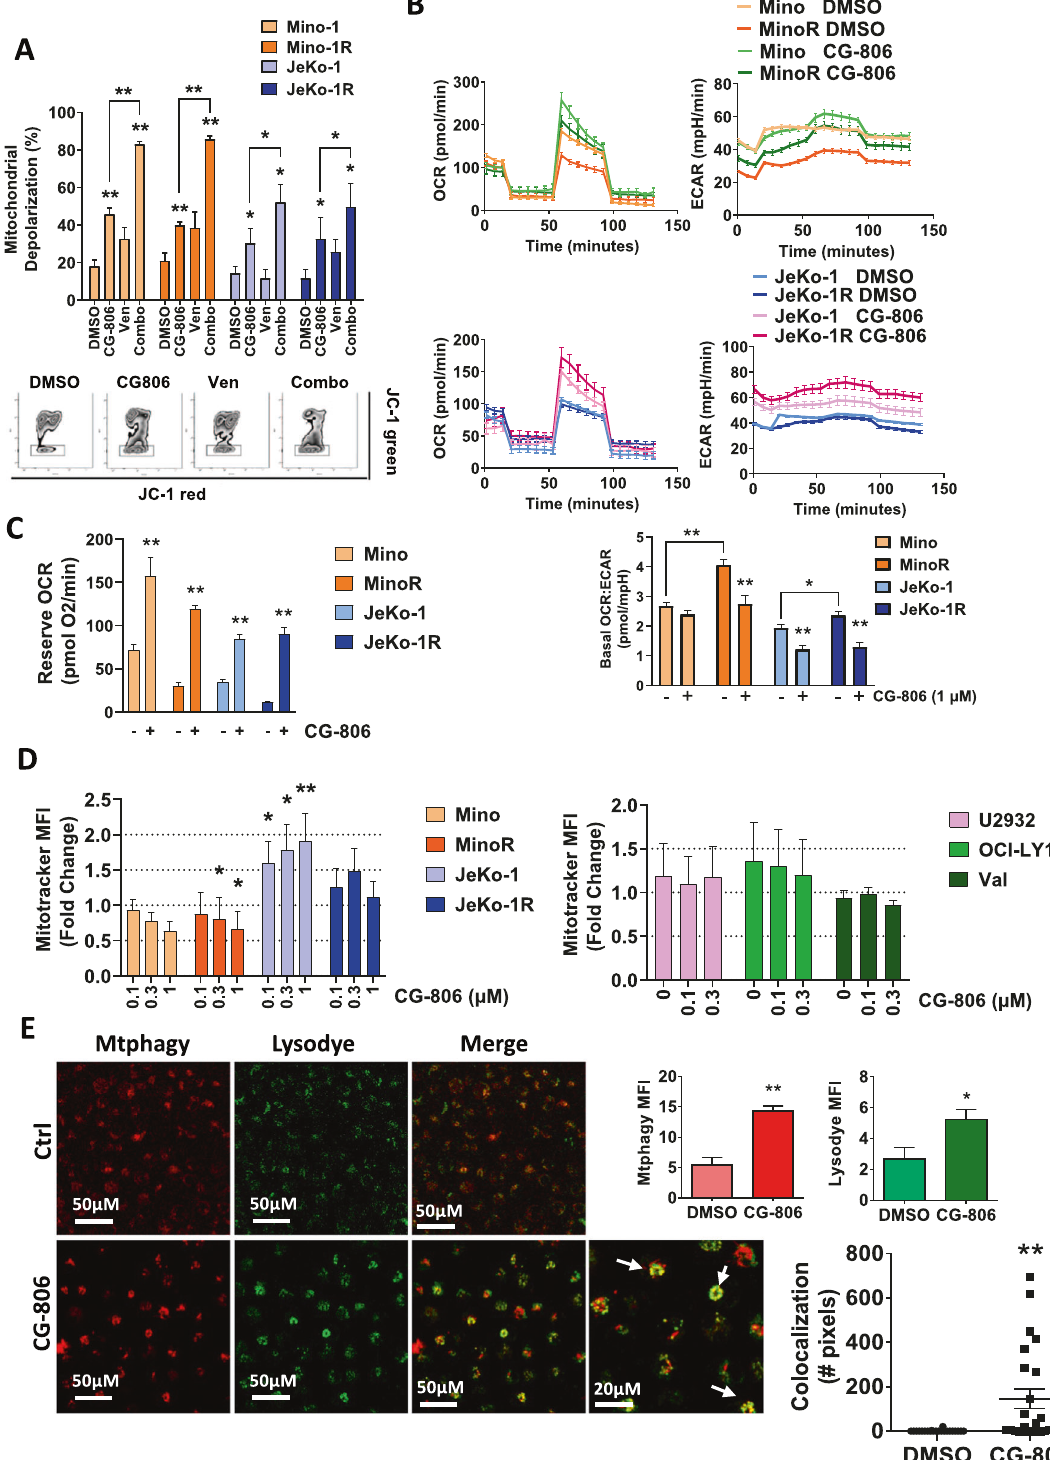
Fig. 2 CG-806 induces mitochondrial damage and metabolic reprogramming. A Cells were treated with CG-806 (1 µM), venetoclax (Ven, 0.1 µM), or combination for 24 h and were analyzed for mitochondrial depolarization with JC-1 dye using fl ow cytometry. Data are presented as mean ± SEM. A representative dot plot image is also shown (depolarized mitochondria are boxed). B , C MCL cells were treated with 1 µM CG-806 or DMSO control for 24 h and subjected to Seahorse analysis measuring oxygen consumption rate (OCR) and extracellular acidi fi cation rate (ECAR). D Cell lines were treated with drug for 24 h as indicated and mitochondrial mass was assessed with Mitobright Green using fl ow cytometry. Data are presented as mean ± SEM. E Mino cells were treated with 1 µM CG-806 vs. control for 24 h and stained with Mtphagy dye (red) and Lysodye (green). Live cells were imaged with confocal microscopy. A representative image is shown. White arrows point to the mitophagy puncta. MFI was quanti fi ed, and colocalization was measured and calculated using Zen software. Data are presented as mean ± SEM and pixel count. * p < 0.05 and ** p < 0.01 vs. control. Cell Death and Disease (2022)